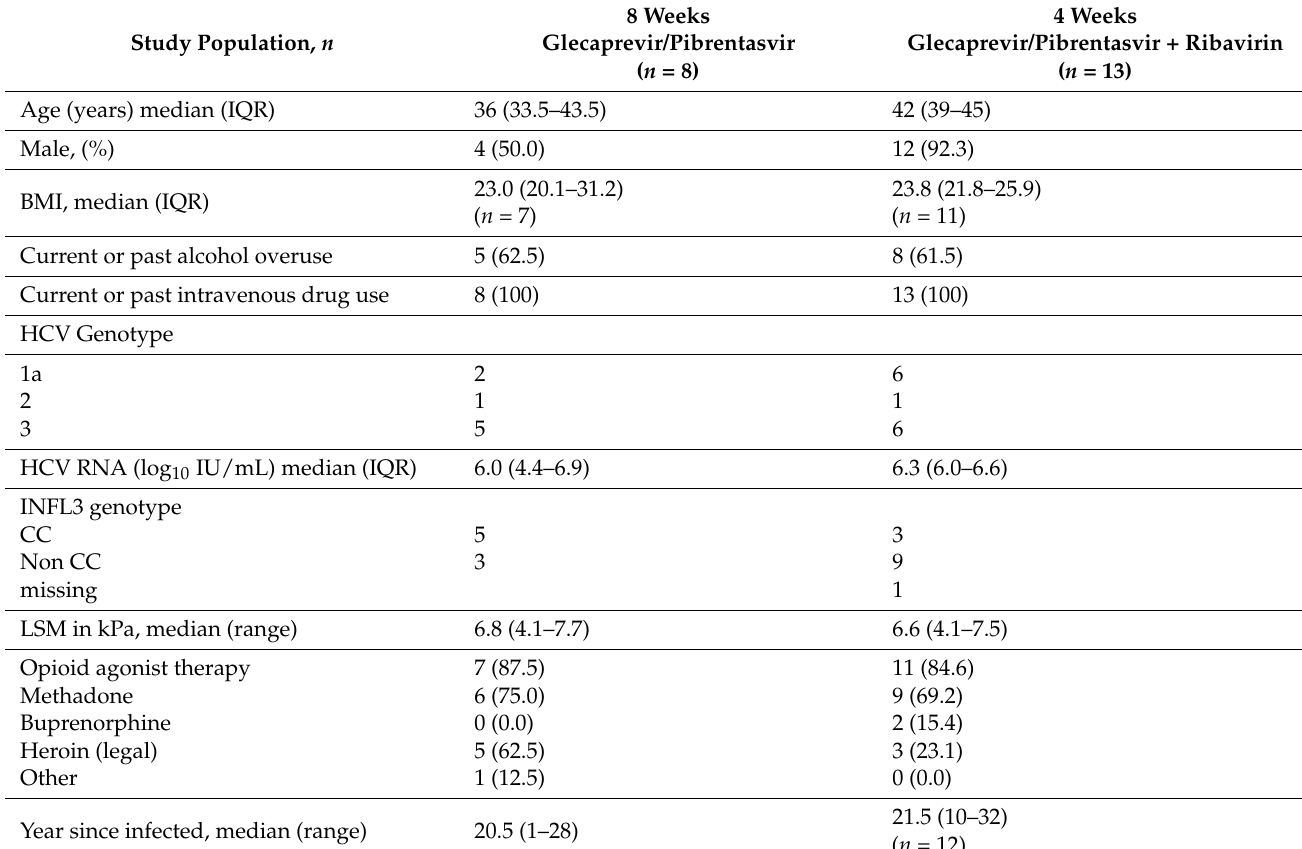
Table 1. Baseline Characteristics from phase 2 of the 4RIBC study for the intention to treat